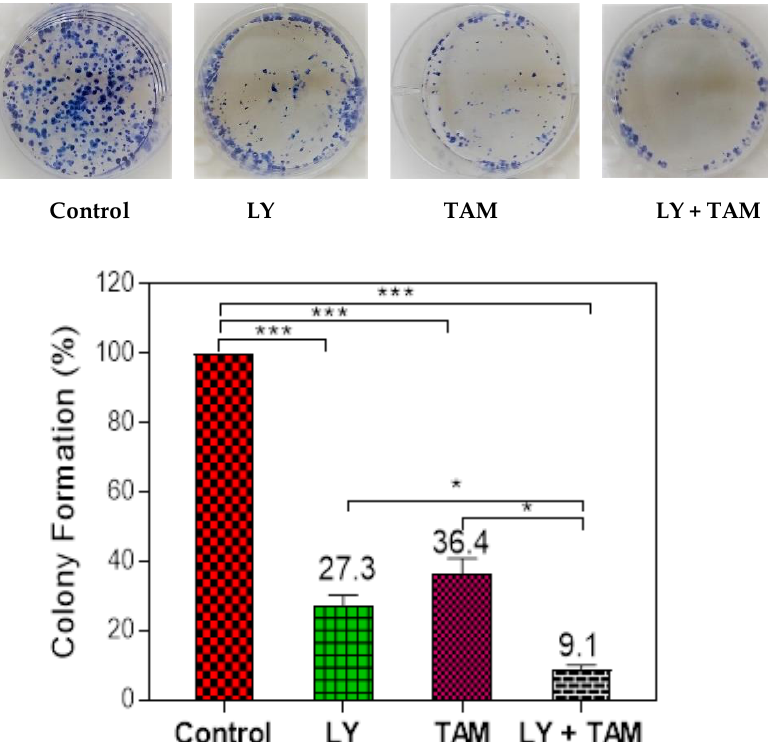
Figure 2. Colony formation assay of MCF-7 cells treated with LY, TAM, and LY + TAM combination. MCF-7 cells were treated for 24 h with the experimental set and cells were seeded in 6-well plates (200 cells / well) and incubated for 14 days. The colonies were counted after staining with methylene blue. The colony formation of the treatment set was quantified as a percentage related to untreated control. Statistical di ff erences, compared with the control cells, were assessed by a one-way ANOVA with the Tukey’s post-hoc multiple comparison test (GraphPad Prism).). p < 0.05 (*), p < 0.001 (***) was taken as